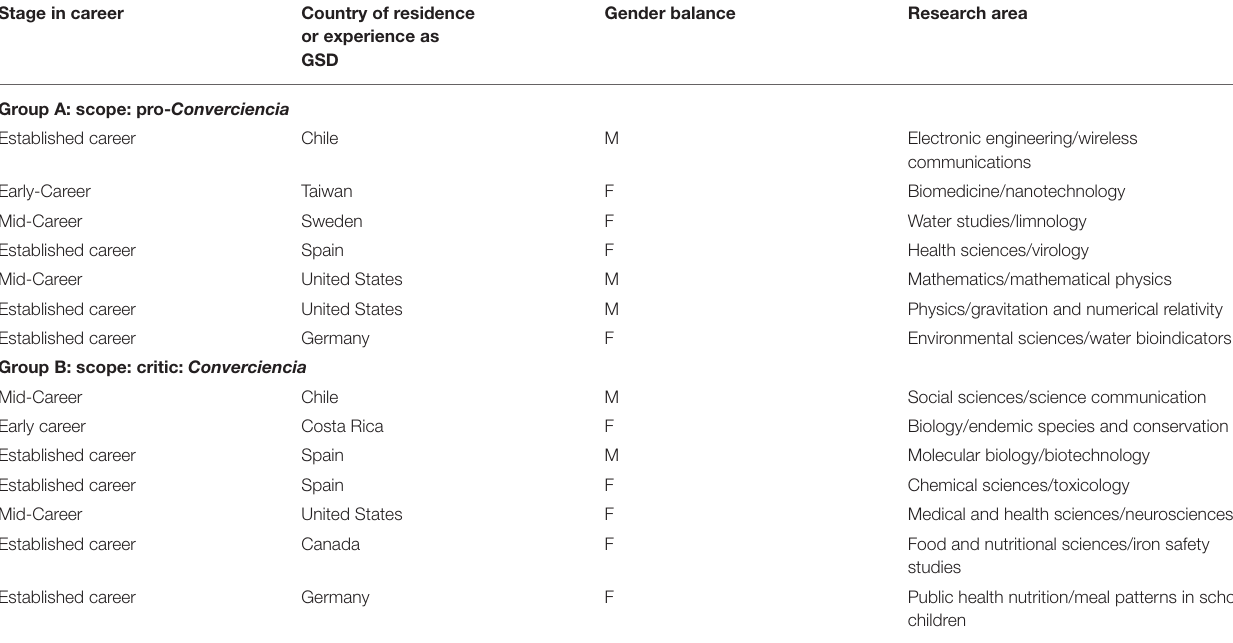
TABLE 3 | Participants from the scientific community, Guatemala scientific diaspora (GSD): two focus group discussions. Stage in career Country of residence or experience as